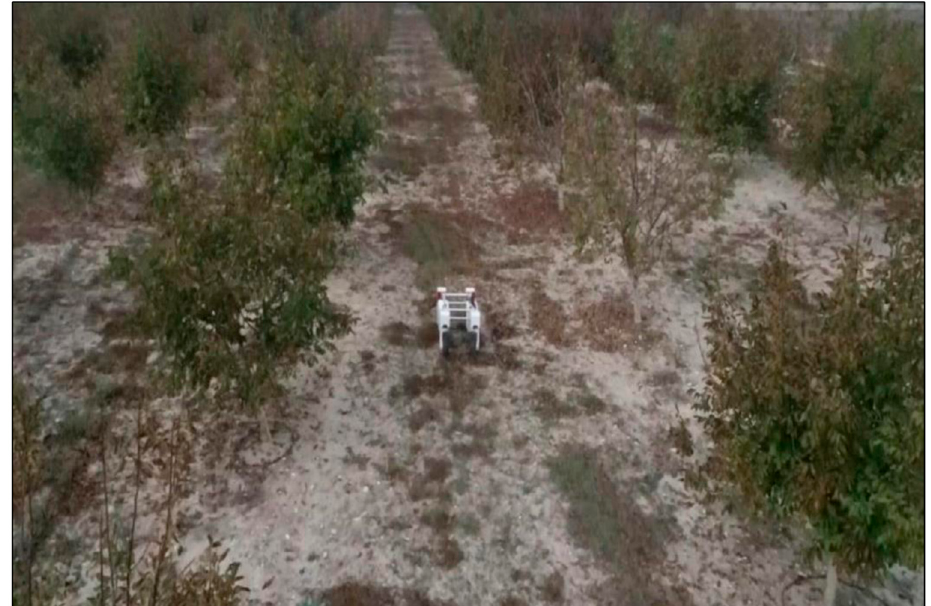
Figure 11. Actual robot used for testing the AgROS emulation model on an actual orchard.